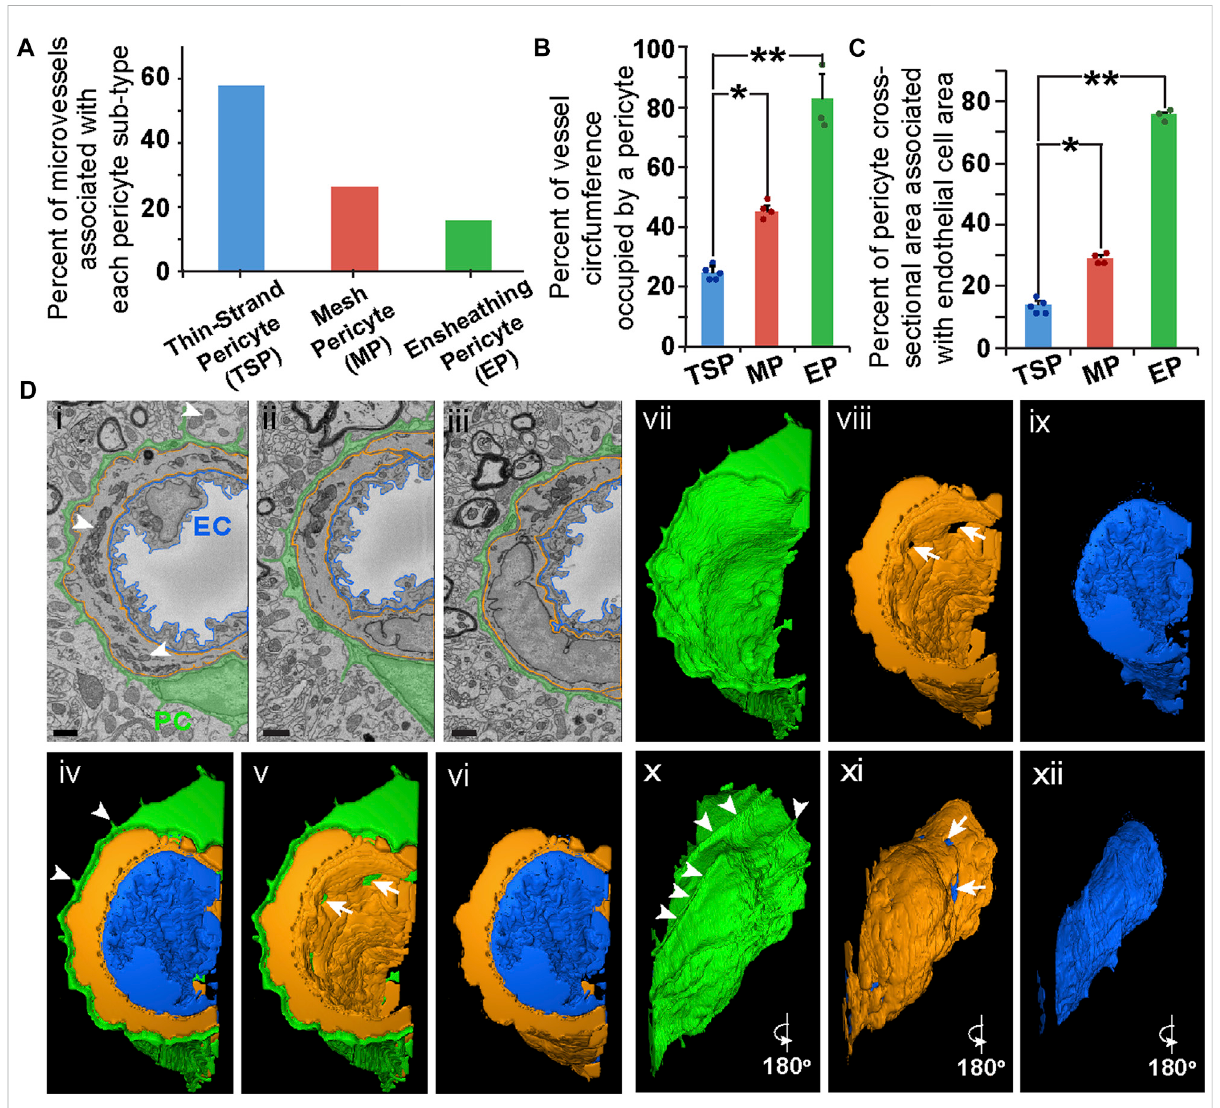
average, the thickest ECM between themselves and the surrounding parenchyma,almostreaching300 nminthickness(Figure3C).These medial cells were also separated from ECs and EPs with ECM akin to the internal elastic lamina (IEL) of arteries, which ranged